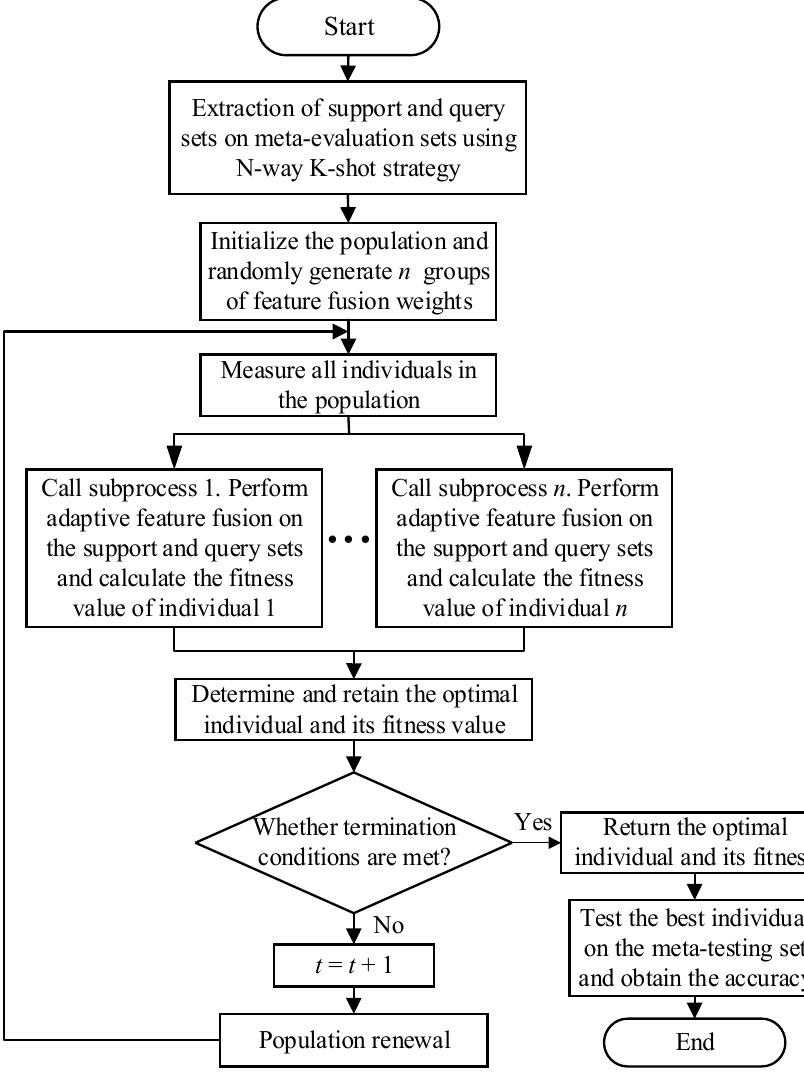
Figure 5. Flow chart of adaptive feature fusion and weight optimization algorithm.